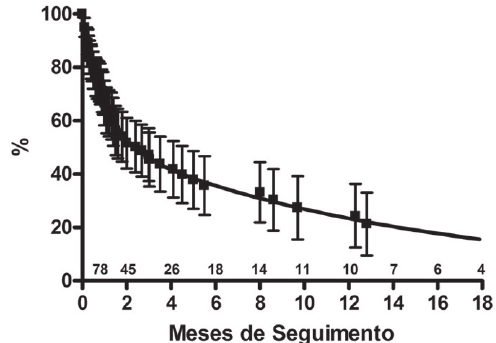
Fig. 2 - Curva de expectativa de vida dos pacientes listados em caráter de prioridade para o transplante cardíaco. Os números indicam os pacientes em risco nos períodos assinalados (média ±